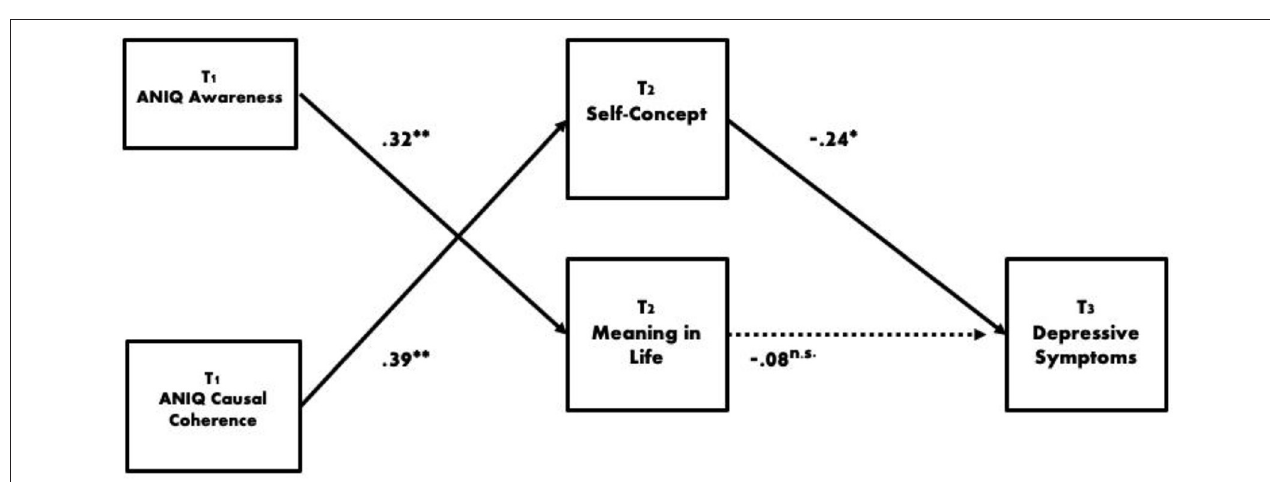
FIGURE 2 | Final model. * p < 0.05, ** p < 0.01. ANIQ, Awareness of Narrative Identity Questionnaire. Indirect standardized effect of ANIQ Causal Coherence on Depressive Symptoms = − 0.10, CI95% L-0.20 U-0.03, p =